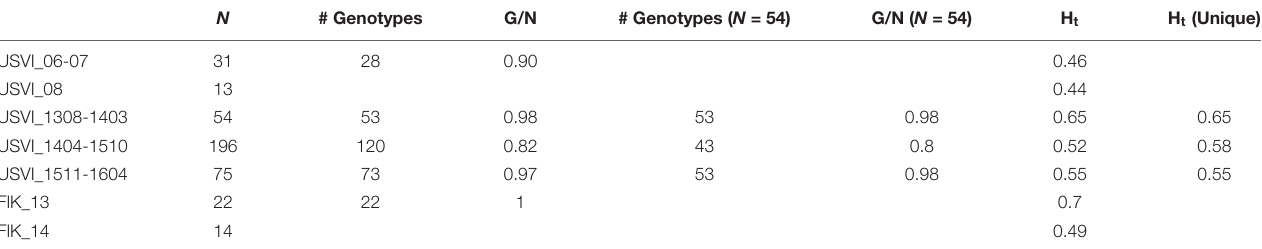
FIGURE 2 | STRUCTURE plots illustrating the number of genetic clusters in the data set based on all seven microsatellite loci. Genotypes are represented as single vertical lines. (A) K = 4 in the entire data set include all samples from the Florida Keys and USVI. (B) K = 2 in a subset of the data: USVI 2006-2008 and Florida Keys 2013 and 2014. (C) K = 3 in the high-resolution sampling period (August 2013–April 2016) at USVI. TABLE 1 | Number of strains per genetic cluster (N), number of different genotypes (# genotypes), genotype diversity (G/N), allele diversity calculated with all strains (H t ), and excluding replicated genotypes (H t unique). N #